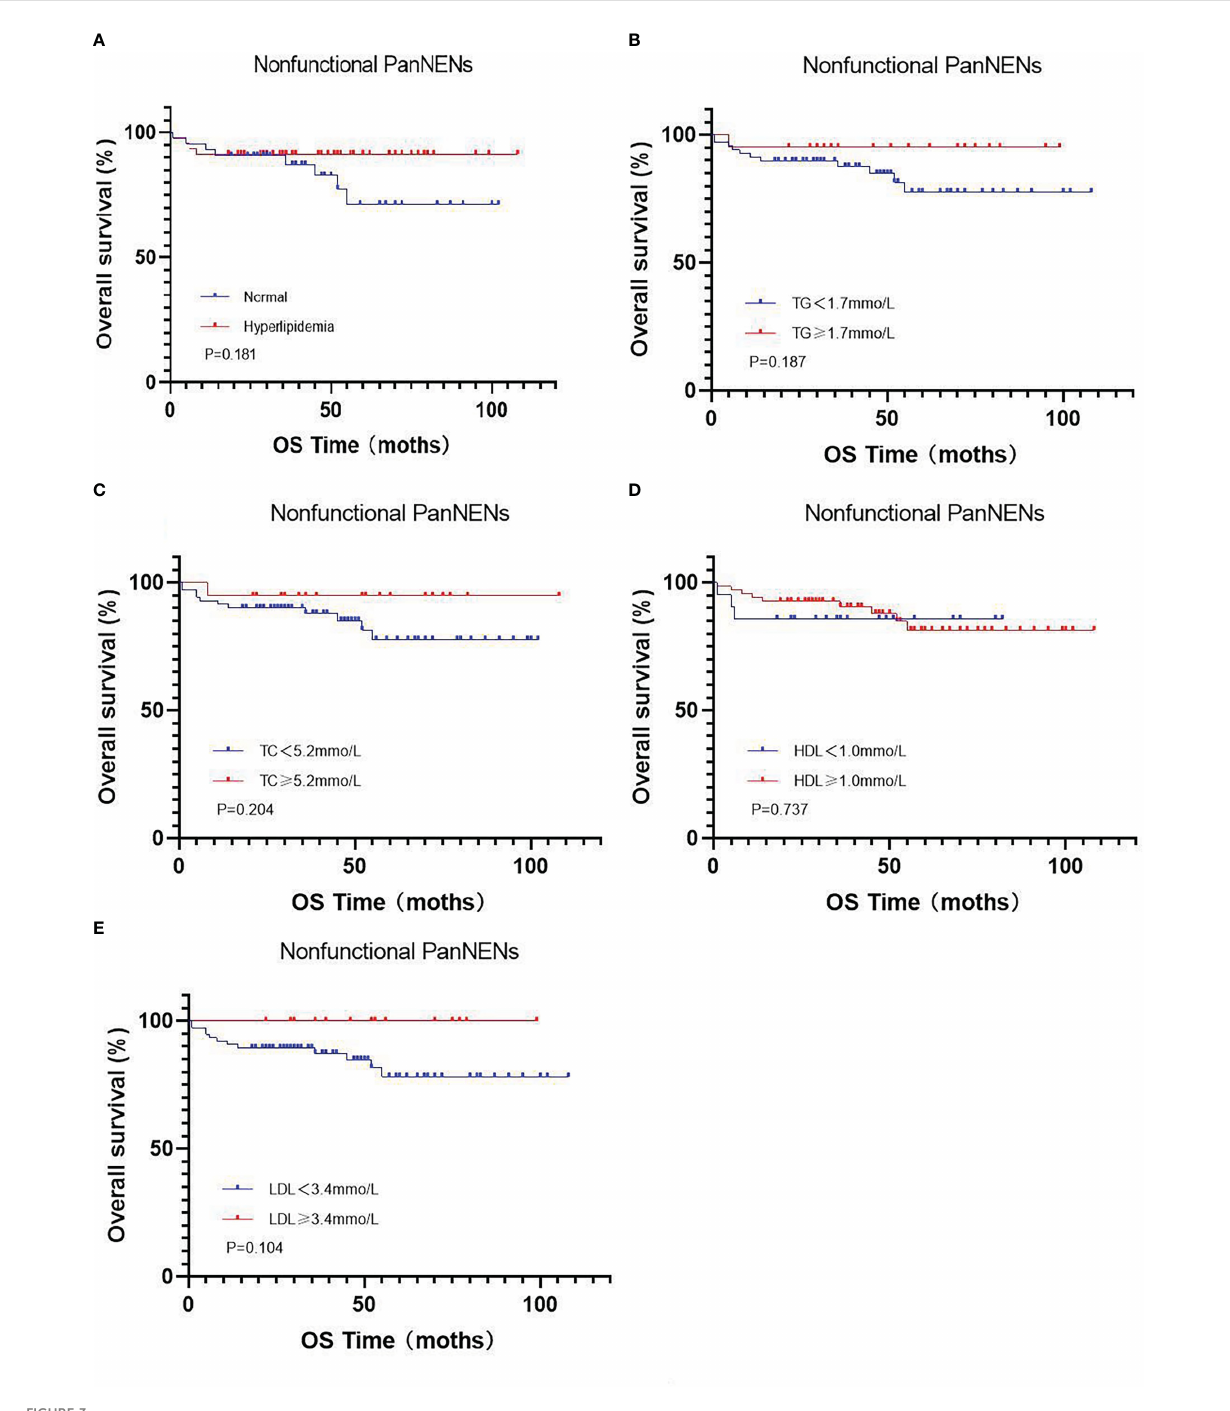
FIGURE 3 Kaplan-Meier curves for OS in the subgroup of nonfunctional PanNENs (A) , regarding hyperlipidemia vs normal serum lipids (P =0.181) (B) , regarding low vs high TG levels (P =0.187) (C) , regarding low vs high TC levels (P =0.204) (D) , regarding low vs high HDL levels (P =0.737) (E) , regarding low vs high LDL levels (P